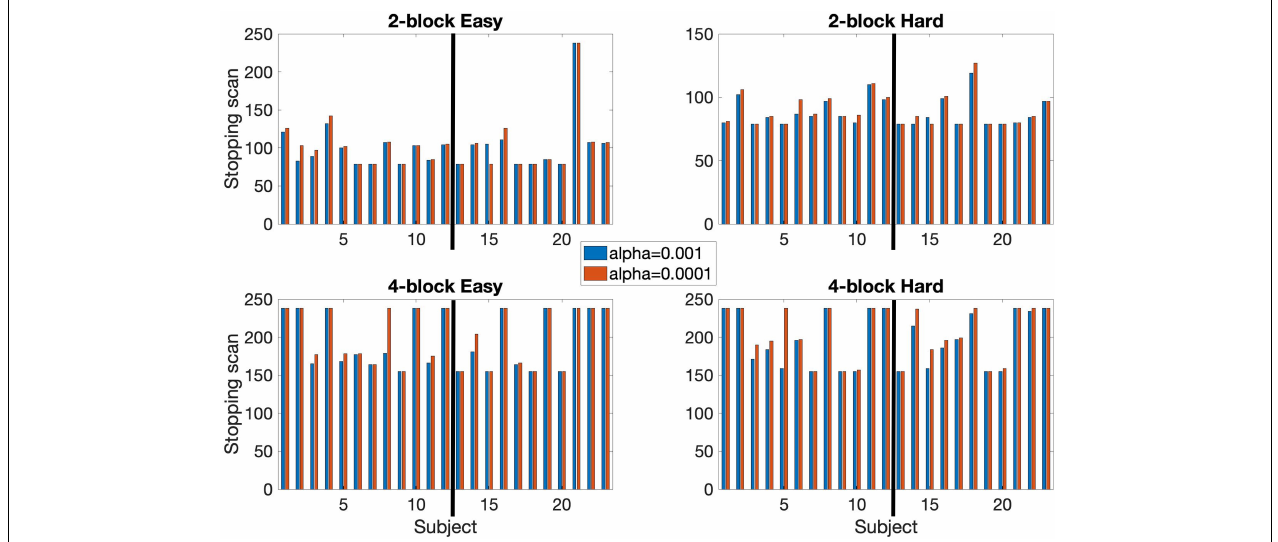
FIGURE 5 | Comparison of early stopping times using α E = 0.001 and α E = 0.0001. Based on 80% of voxels being classified. Both 2-block (top row) and 4-block (bottom row) first stage conditions are presented. β E = 0.1 throughout. The thick black line in each chart indicates the subject groups. Left of the black line